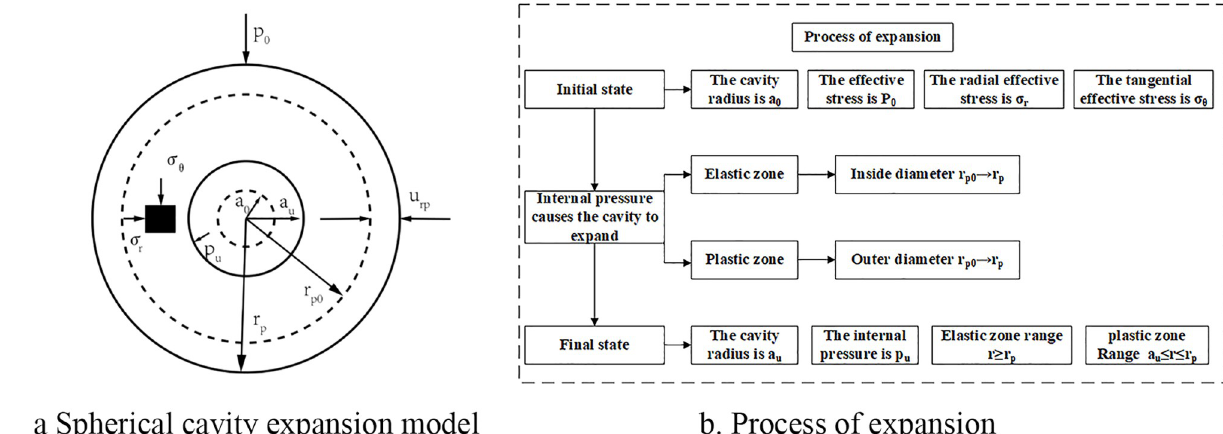
Fig 1. Diagram of spherical cavity expansion